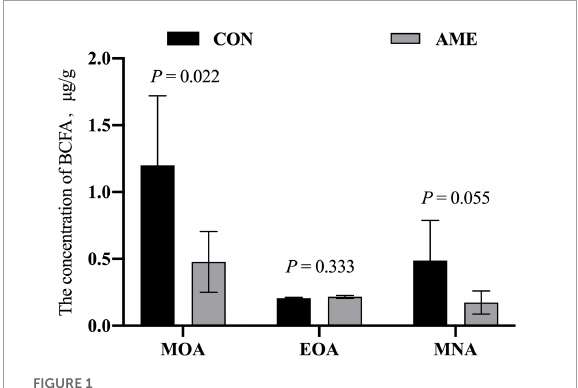
FIGURE1 Effect of AME on the concentration of BCFAs in the rumen of lambs. CON, basal diet; AME, basal diet + 2.8 g · lamb − 1 · d − 1 A. mongolicum Regel ethanol extract (AME).